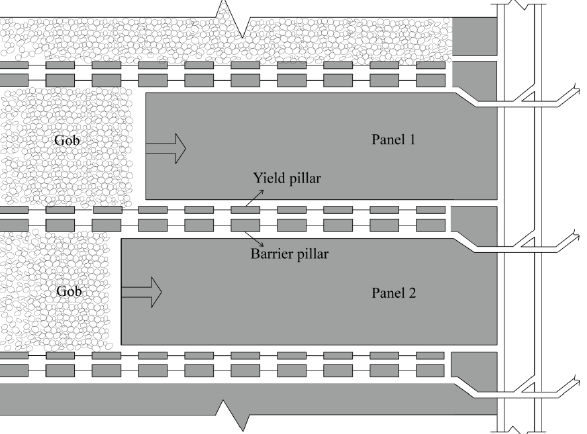
Figure 18. Layout of twin longwall panels with standalone haulage and ventilation systems and quasi-synchronous panel advance for the effective control of well stability. quasi-synchronous panel advance for the effective control of well